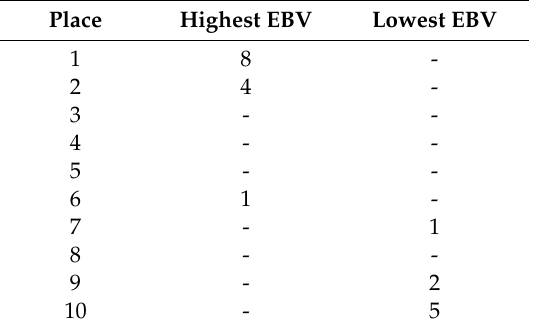
breeding value (EBV) for the liability of the ranking trait.